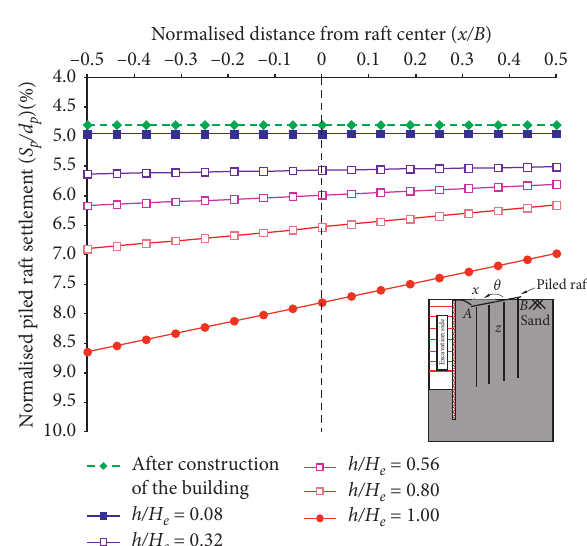
Figure 7: Evolution of differential settlement in the raft.